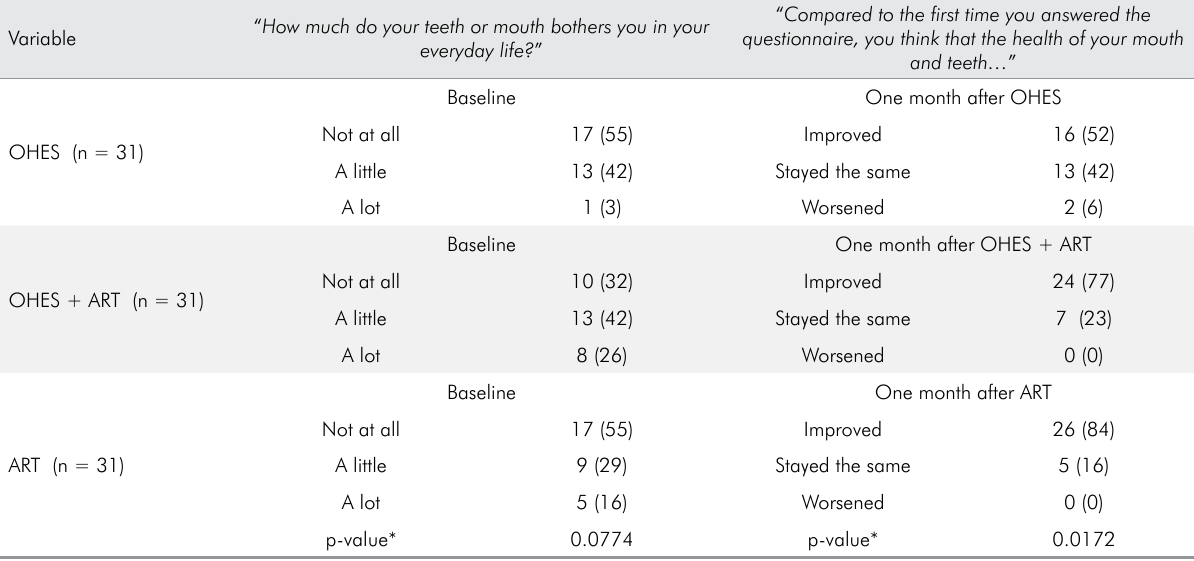
Table 2. Frequency [n (%)] of global oral health and overall well-being responses according to groups and follow-up time. Variable